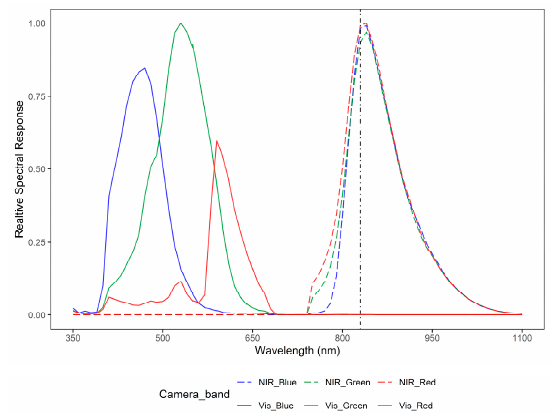
Figure 2. Relative Spectral response of the two Sony cameras used in this study. Vertical dotted line indicates the 830 nm blocking filter present in the adapted Sony NIR camera. Table 3. Sony α 5100 camera band sensitivities. Sensitivities were measured using a double